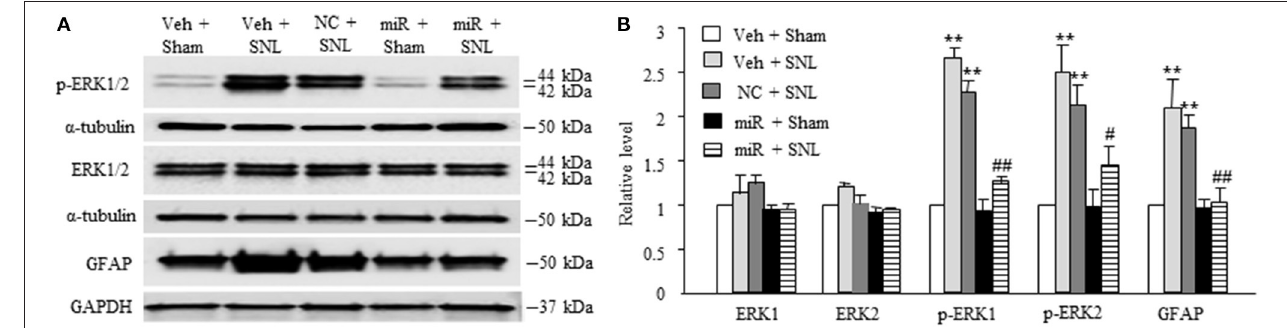
FIGURE 5 | Rescuing DRG miR-143 expression alleviated central sensitization in spinal dorsal horn. miR, microRNA; NC, negative control; SNL, spinal nerve ligation; Veh, vehicle; Microinjection of miR-143 mimics, but not negative control, into the ipsilateral L5 DRG significantly attenuated SNL-induced increases in the levels of phosphorylated extracellular signal-regulated kinases ½ (p-ERK1/2) and glial fibrillary acidic protein (GFAP) in the ipsilateral L5 dorsal horn on day 7 post-SNL. (A) representative Western blots. (B) statistical summary of the densitometric analysis. n = 6 rats/group. One-way ANOVA followed by Tukey post-hoc test. ** P <